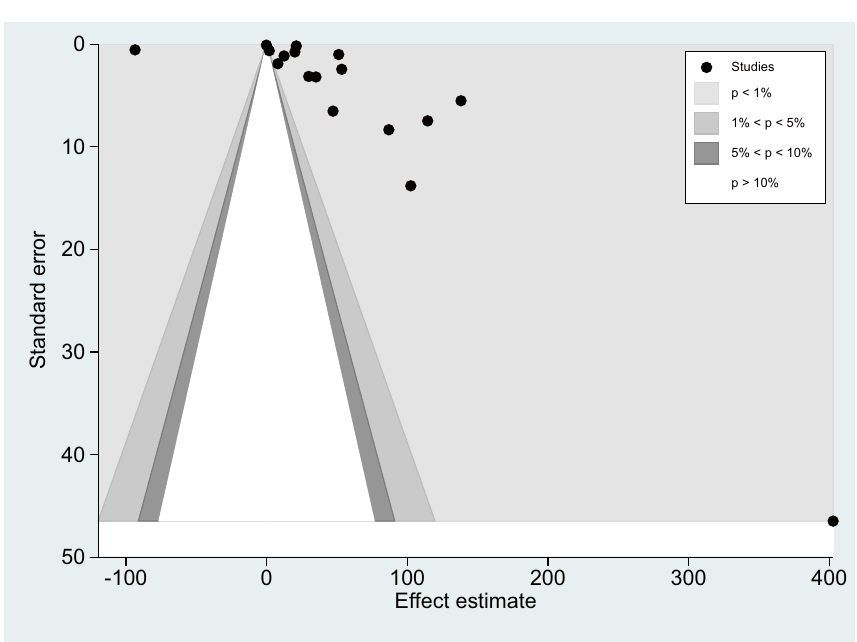
Figure 19. The contour-enhanced funnel plot demonstrated the effect estimates (WMD) were located in a significant area ( P < 1%, 0.01), indicating that the cause of the funnel plot asymmetry was due to publication bias rather than other